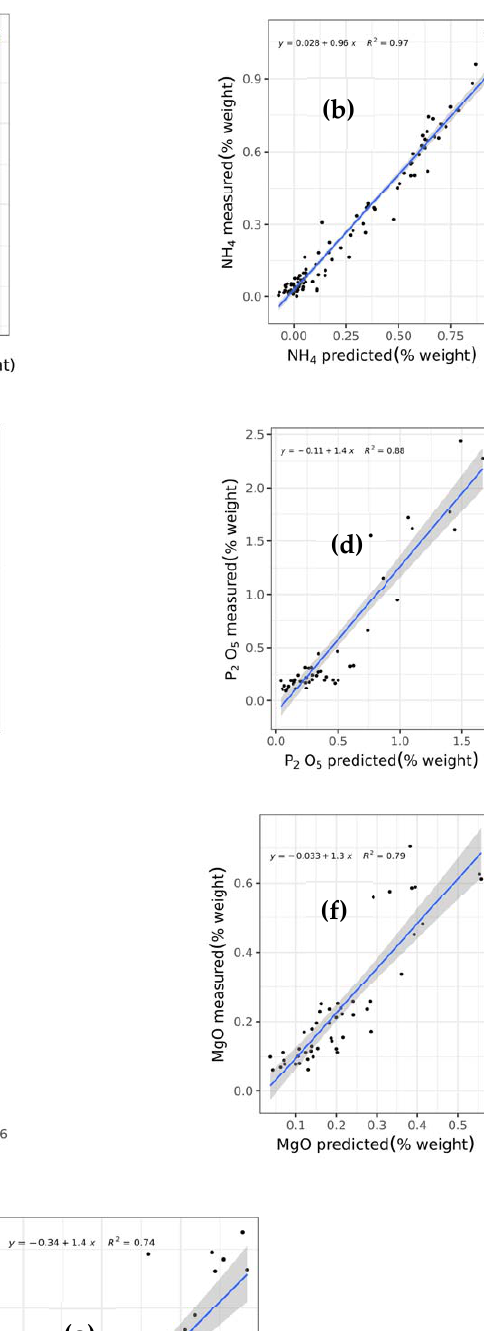
Based on the RPD analyses, stacked regression generated excellent models for DM,